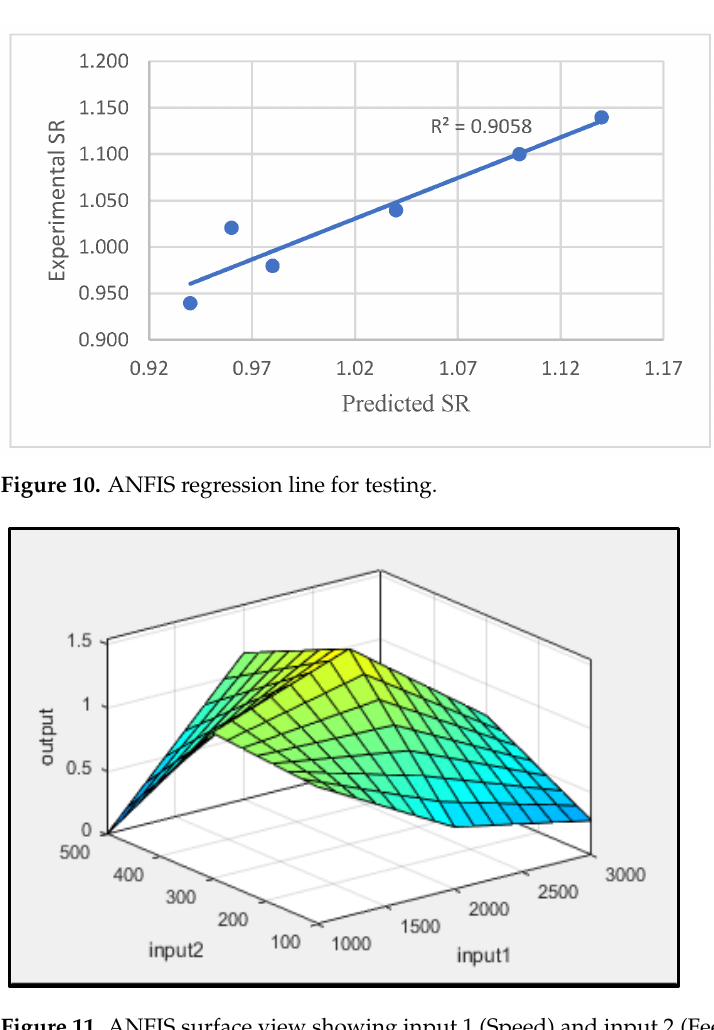
Figure 11. ANFIS surface view showing input 1 (Speed) and input 2 (Feed) Vs the output (SR).